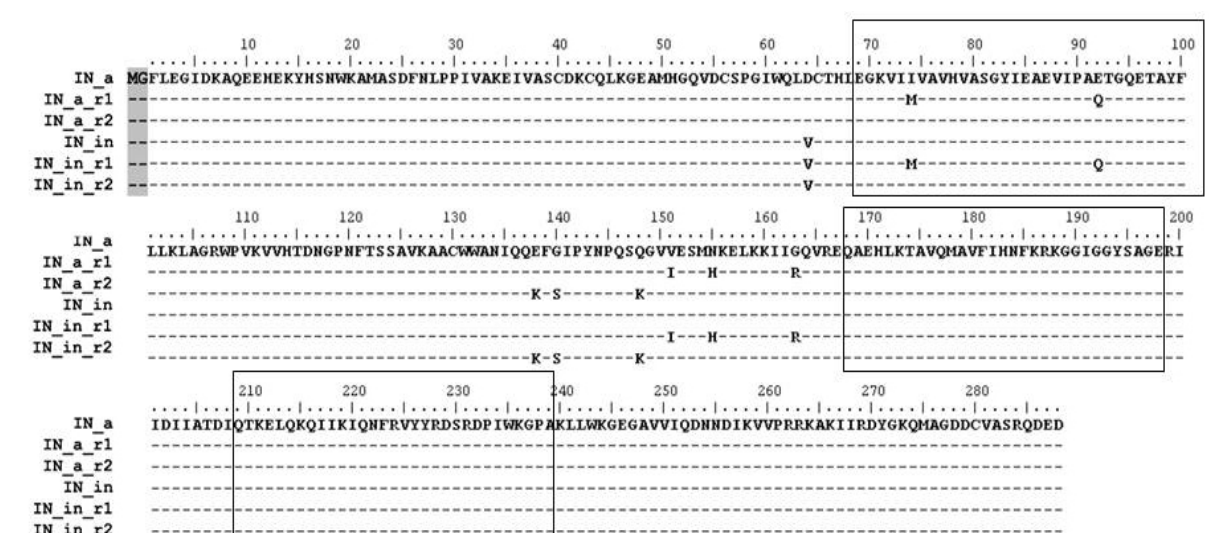
Figure 1. Consensus integrases of HIV-1 clade A FSU_A strain and their enzymatically active and inactivated variants with mutations of resistance to RAL. Amino acid sequences of the consensus IN of HIV-1 subtype A (IN_a), RAL-resistant INs with mutations L74M, E92Q, V151I, N155H, G163R (IN_a_r1) or E138K, G140S, Q148K (IN_a_r2) [25] and their inactivated variants with D64V mutation (IN_in, IN_in_r1, IN_in_r2). All IN variants carry Met-Gly dipeptide on the N-terminus (shadowed) originating from introduction of the Kozak sequence at the 5 ′ -terminus of IN gene. Amino acid numeration is started at Phe as the 1-st amino acid in the wild-type IN. Boxes mark clusters of B- and T-cell epitopes of IN recognized in different species (see Supplementary Figure S1 for details).